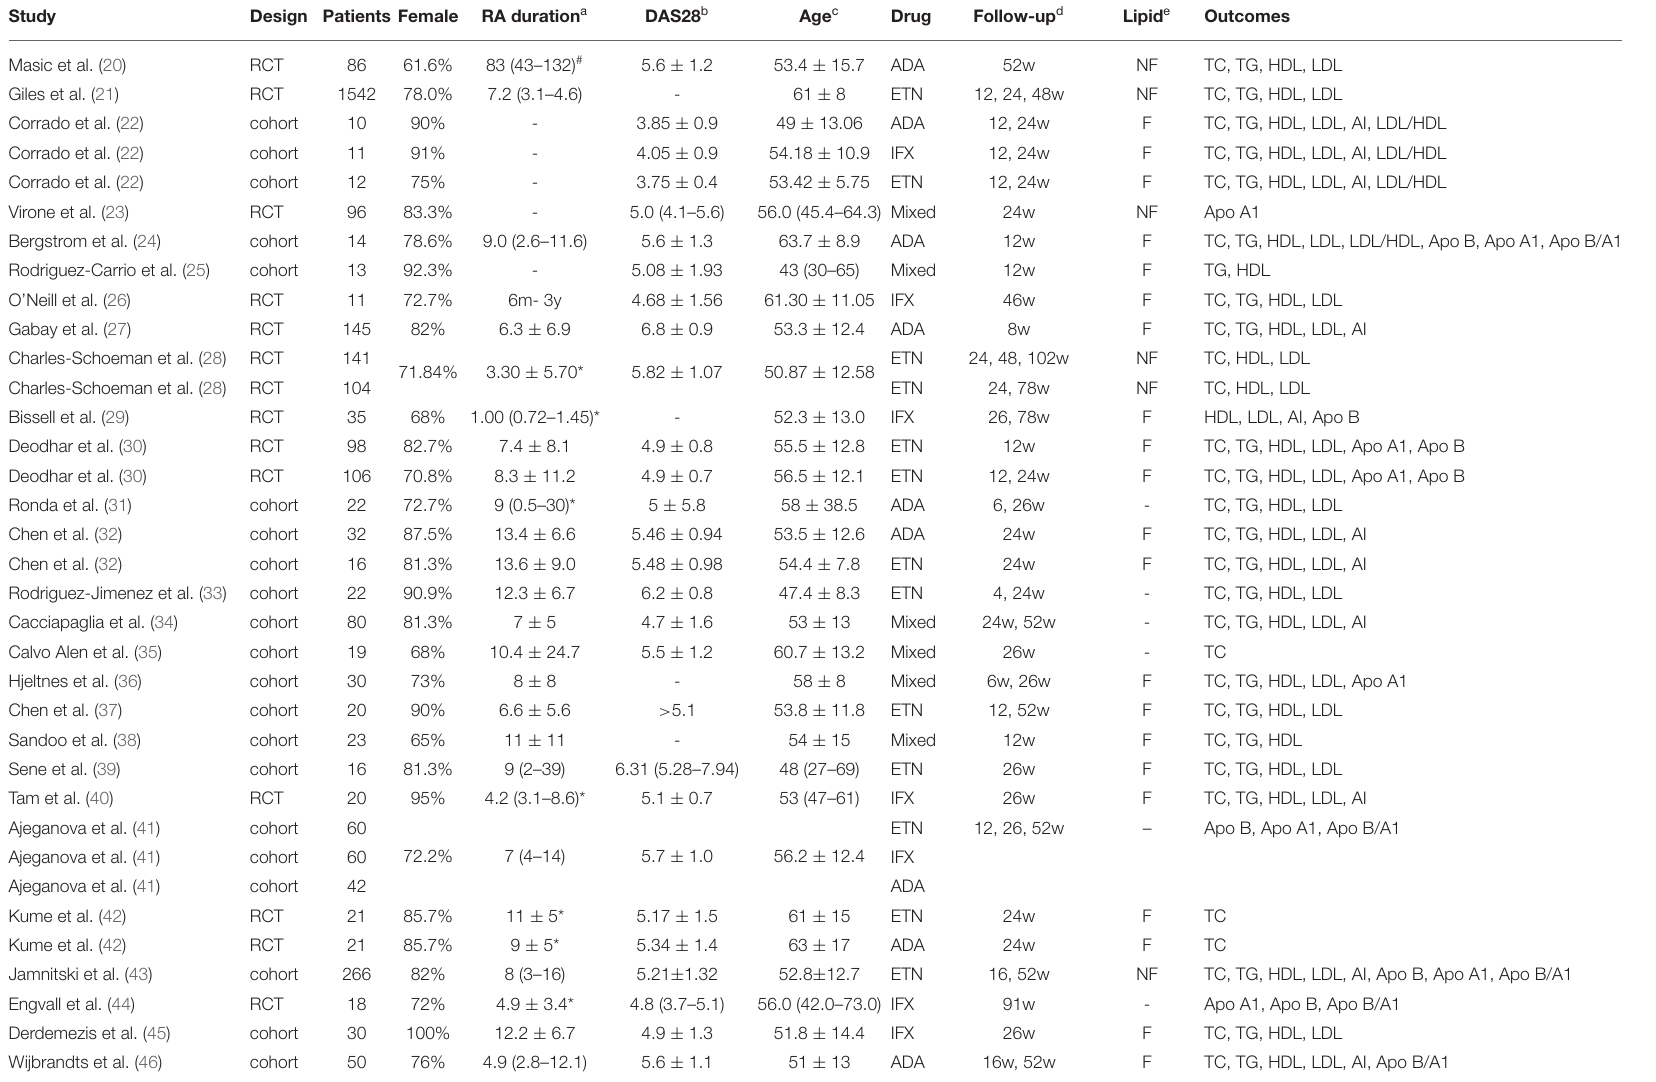
TABLE 1 | Summary of the included